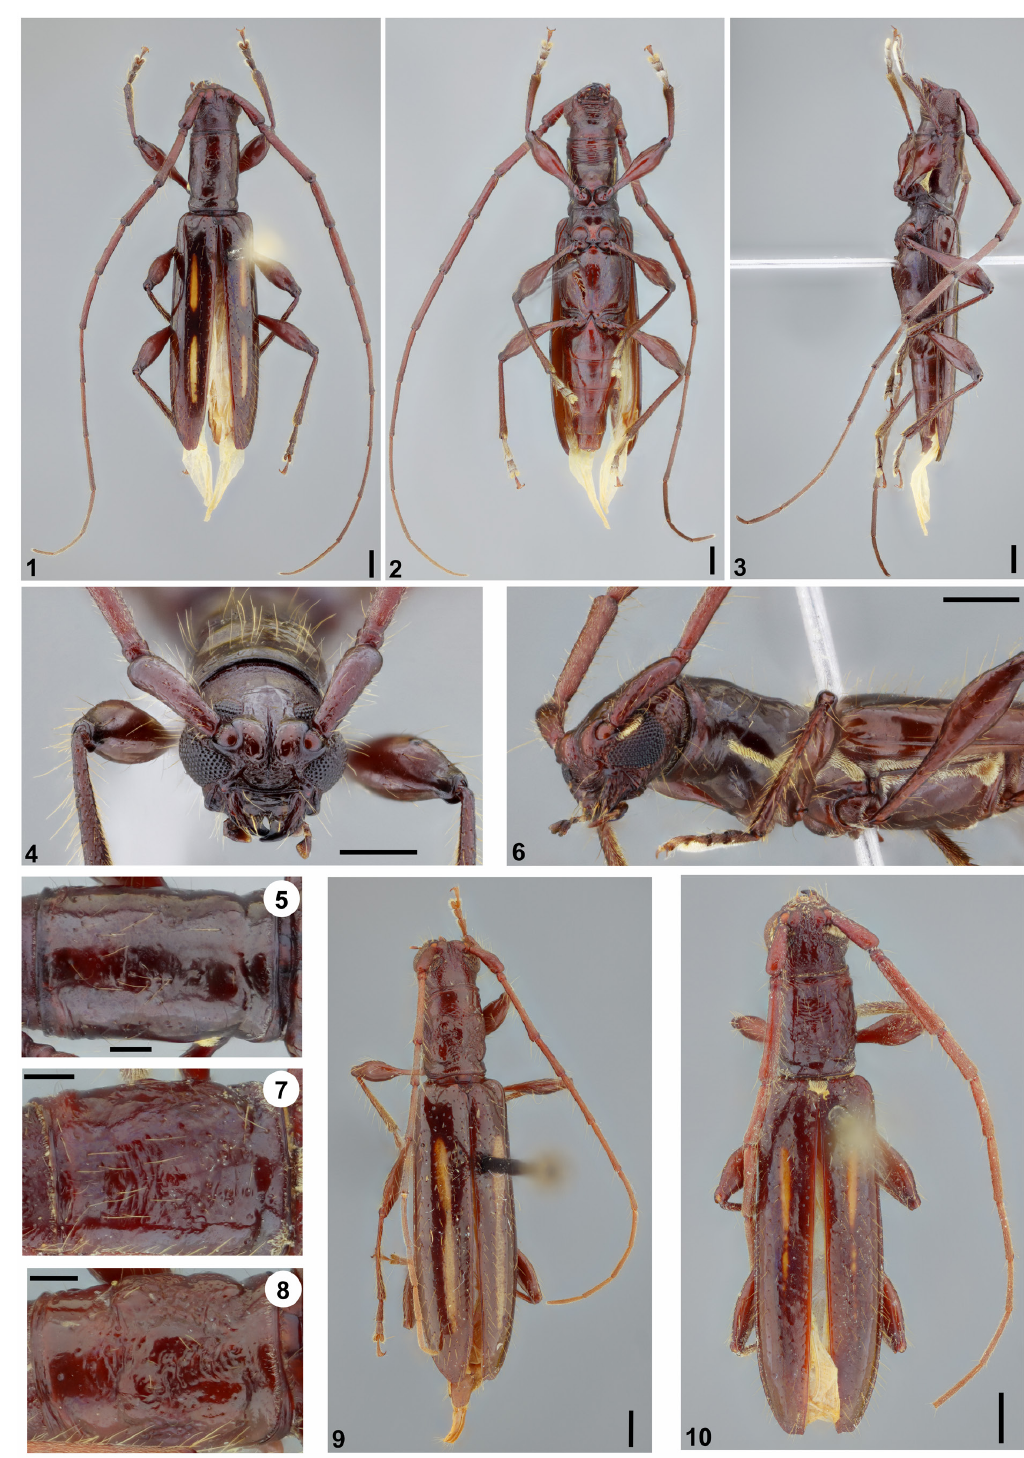
Figs 1–10. 1–6 . Heterachthes caceresae sp. nov. 1–5 . Holotype, ♂ (RBINS 34.248). 1 . Habitus, dorsal view. 2 . Habitus, ventral view. 3 . Habitus, lateral view. 4 . Head, frontal view. 5 . Pronotum. 6 . Paratype, ♂ (MZSP). Partial lateral habitus. — 7–10 . Heterachthes viticulus Martins, 1970. 7 . Paratype, ♂ (MZSP), pronotum. 8 . Paratype, ♀ (MZSP), pronotum. 9 . Paratype, ♀ (MZSP), dorsal habitus. 10 . Paratype, ♂ (MZSP), dorsal habitus. Scale bars: 1–4, 6, 9–10 = 1.0 mm; 5, 7–8 = 0.5